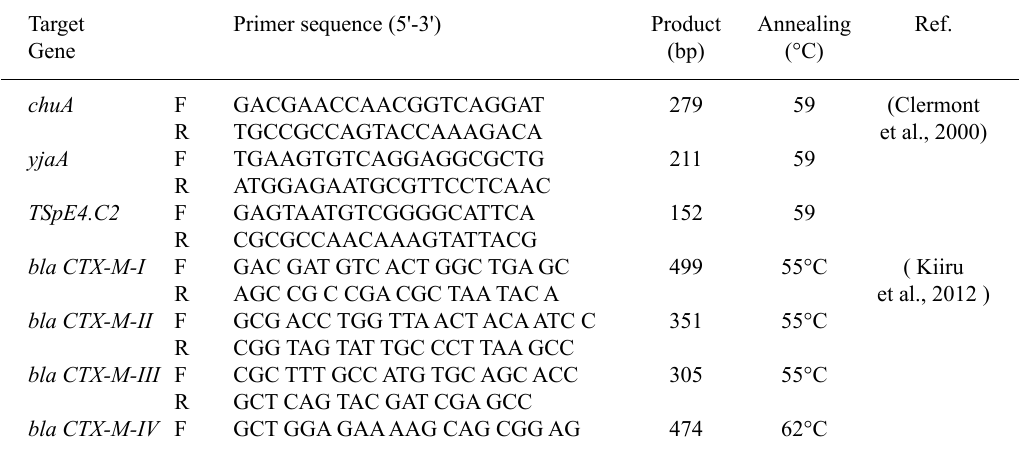
Table 1. Primer pairs with amplicon size for blaCTX-M genotyping